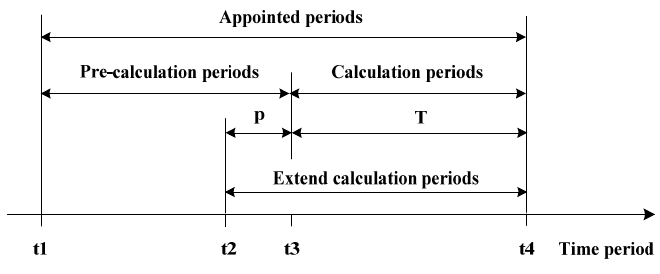
Figure 1. Sketch map of the time relationship.